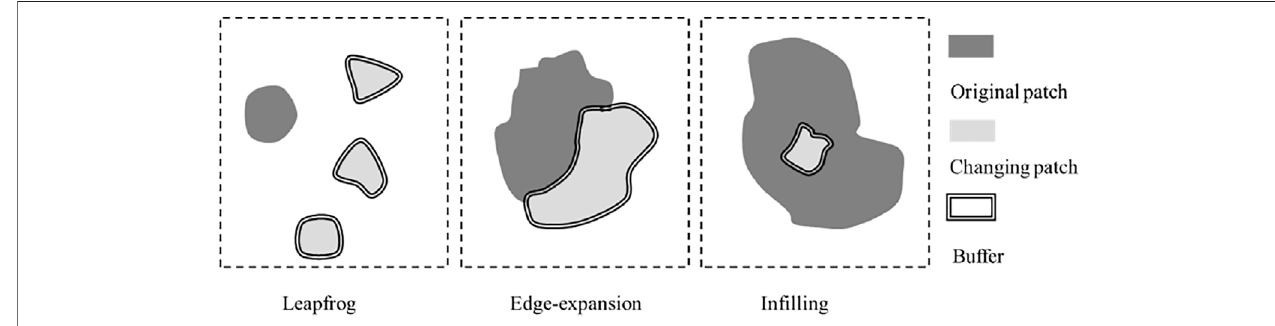
FIGURE 4 | Diagram of RRL patch change process (where “ RCI" = 0 means the change patch is separated from the original site, which is leapfrog; “ 0 < RCI ≤ 50 ″ meansthechangepatchisedge-adjacenttotheoriginalsitepatch,whichisedge-expansion; “ 50 < RCI ≤ 100 ″ meansthechangepatchisintheoriginalsitepatch,which is in fi